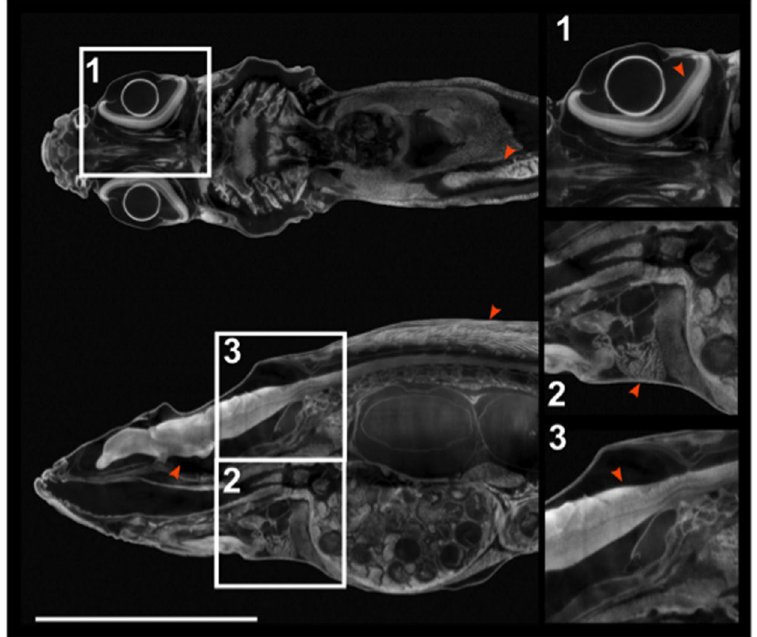
Figure 3. Micro CT of a juvenile zebrafish. Coronal and sagittal virtual sections of a 38 dpf zebrafish stained with PTA. Boxed regions are shown in higher magnification. As in adult medaka, all tissues and body regions show high and differential contrast: ( 1 ) eye, note distinct layers of neural retina (red arrowhead); ( 2 ) heart (red arrowhead); ( 3 ) brain (red arrowhead). Scale bar: 6